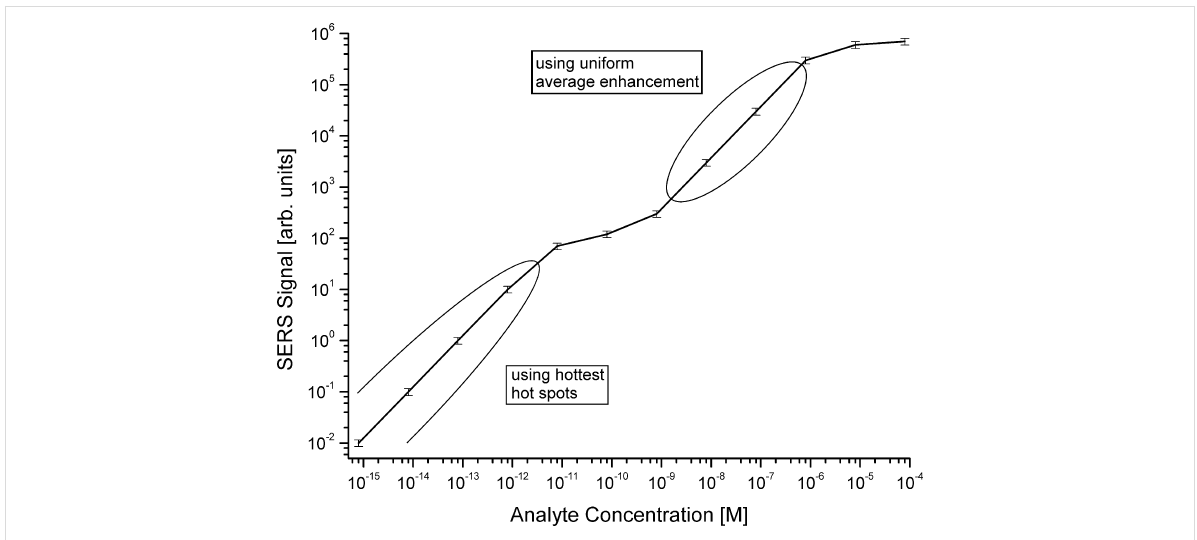
Figure 6: SERS signal of the 1510 cm − 1 Raman line of rhodamine 6G (see Figure 7) vs concentrations of the molecule between 10 − 15 and 10 − 6 M, excitation at 830 nm.